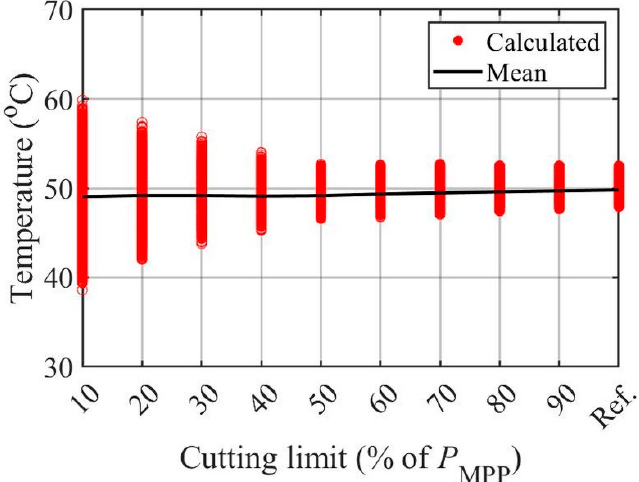
Figure 9. Fitted temperature values during the 40 min measurement period as a function of the cutting limit based on MPP power.